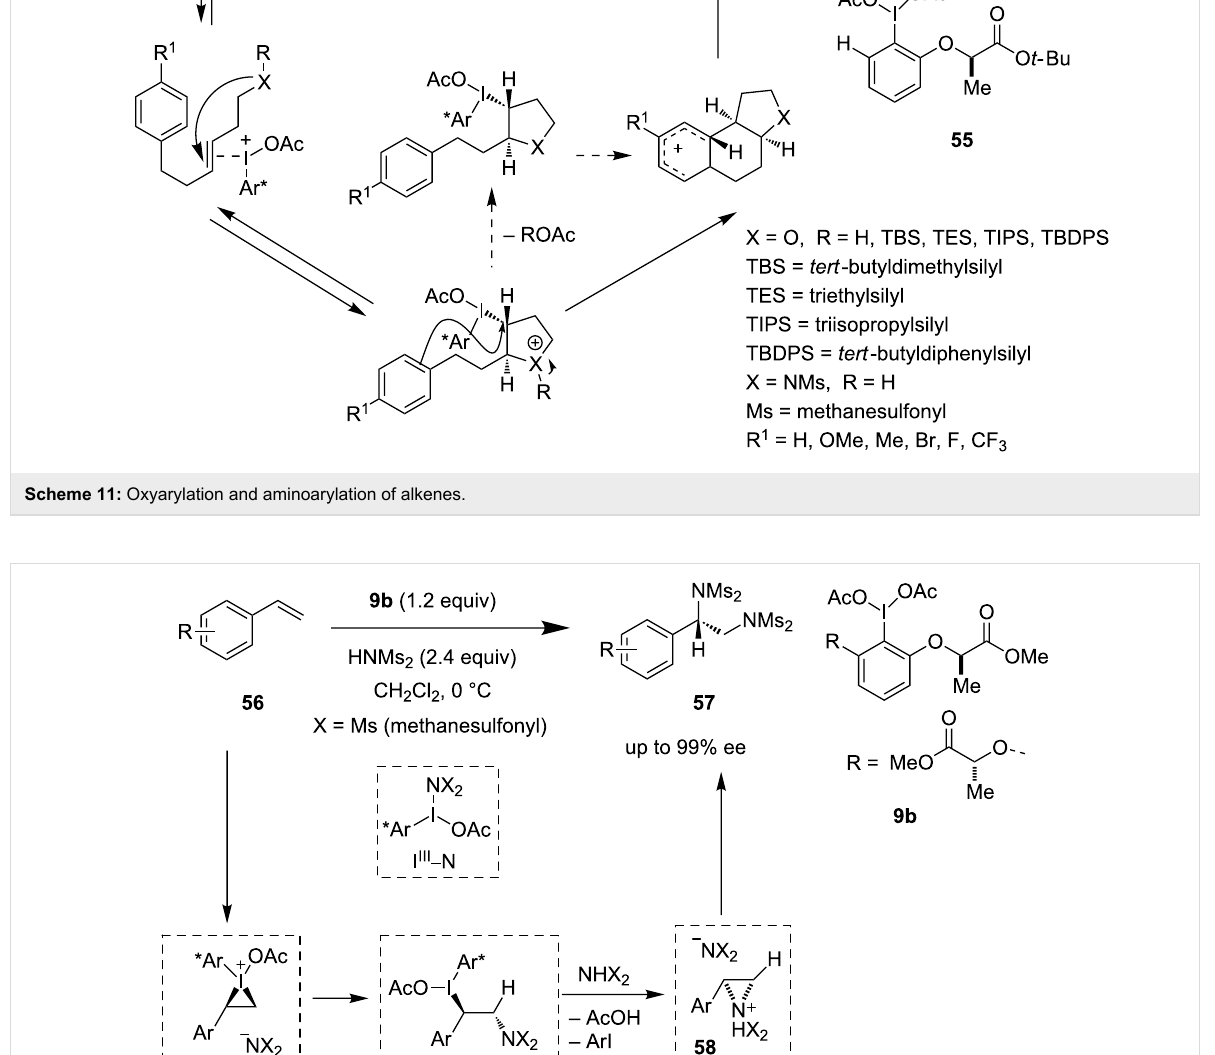
nium salt 13 for the asymmetric synthesis of aminofluorinated compounds 66 from 65 (Scheme 14). In addition to this, they extended this methodology for the regioselective intermolecu- lar aminofluorination of styrenes with a racemic catalyst. The nucleophilic attack of the nitrogen atom onto the alkene (inter- mediate 67 ) to generate aziridinium ion 68 is the crucial step in this